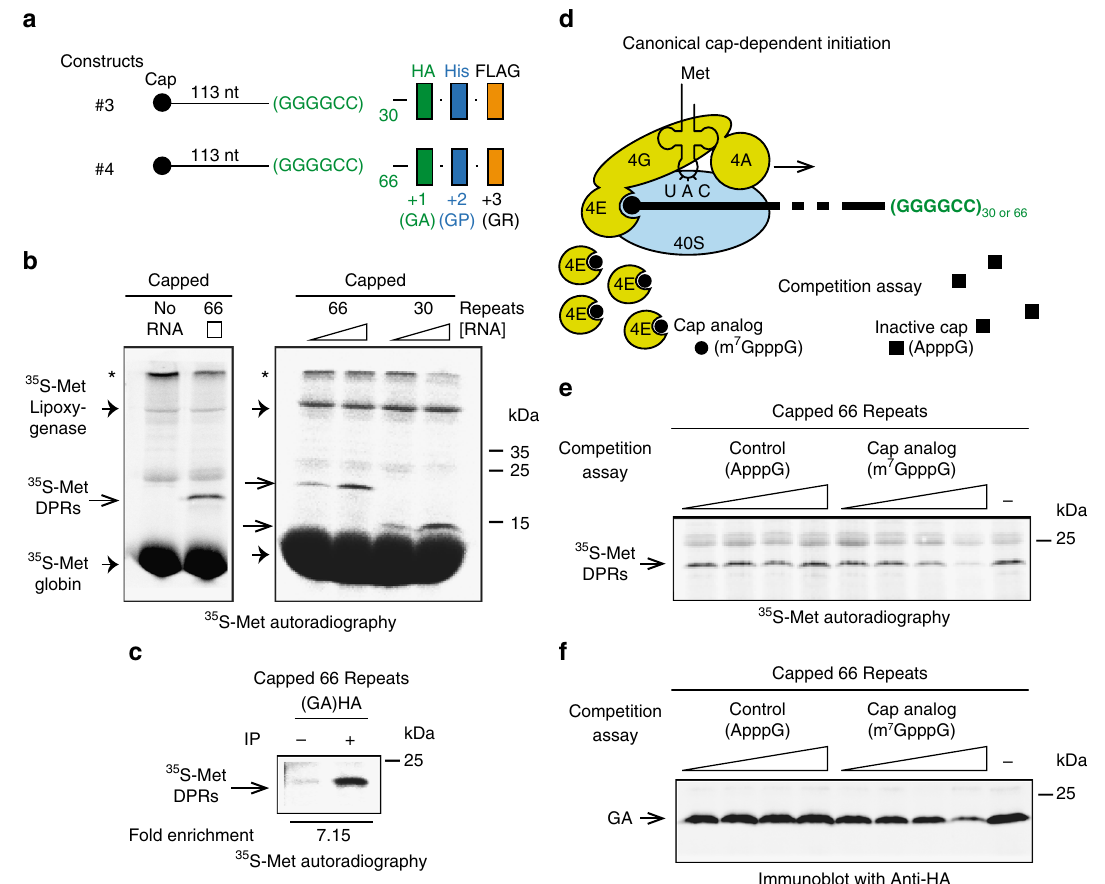
Fig. 2 G 4 C 2 RAN translation is cap-dependent and initiates with a methionine. ( a ) Schemes of the RNA with (G 4 C 2 ) 30 (#3) or (G 4 C 2 ) 66 (#4) repeats that were transcribed in vitro with T7 RNA polymerase, capped and subjected to translation in RRL. ( b ) Translation was performed in the presence of [ 35 S]- methionine and capped RNA #3 or #4 at 100 and 200 nM. RAN translation products were detected by autoradiography. Asterisk indicates bands in the stacking gel. ( c ) Translation was performed in presence of [ 35 S]-methionine and capped RNA #4 followed by immunoprecipitation with antibody against HA-tag and detection of immunoprecipitated [ 35 S]-methionine proteins by autoradiography. ( d ) Scheme of the canonical translation involving the cap- binding protein eukaryotic initiation factor 4E (eIF4E), the protein platform (eIF4G) and the helicase (eIF4A) that recruit the 40S ribosomal subunit. This pre-initiation complex scans the 5 ′ of the transcript for an appropriate start codon. Compounds used for the competition assay in ( e ) and ( f ) are represented by dark circles and squares for the cap analog (m 7 GpppG) and the inactive form (ApppG), respectively. (e – f ) Translation was performed